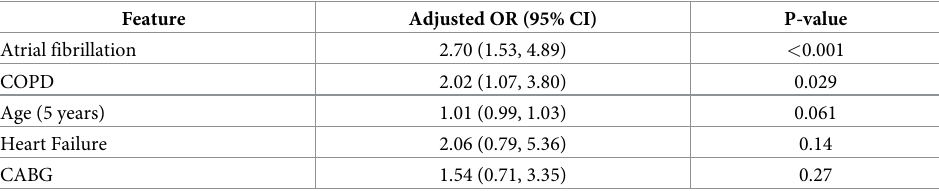
Table 5. Factors associated with high grade post-operative complications with multi-regression